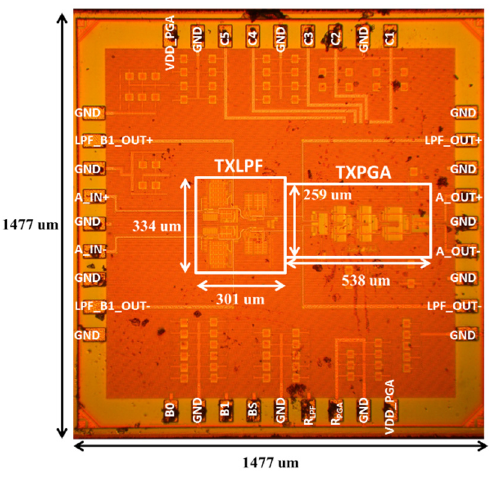
Figure 10. Chip photo of the 5G transmitter (TX) analog baseband.